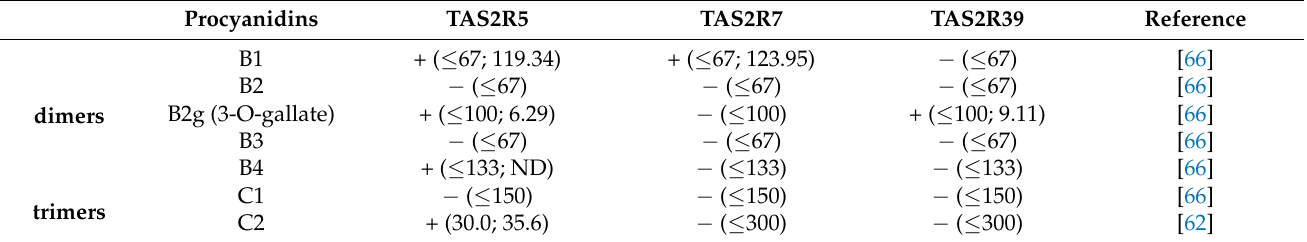
Table 6. hTAS2Rs activated by dimer and trimer condensed tannins identified in pulses (beans *, faba beans and